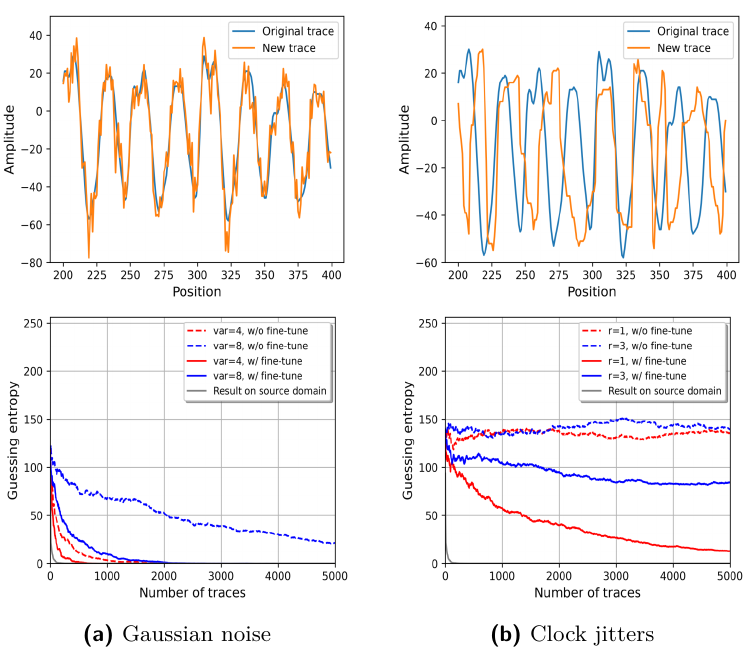
Figure 12: Example traces (top) and attack results